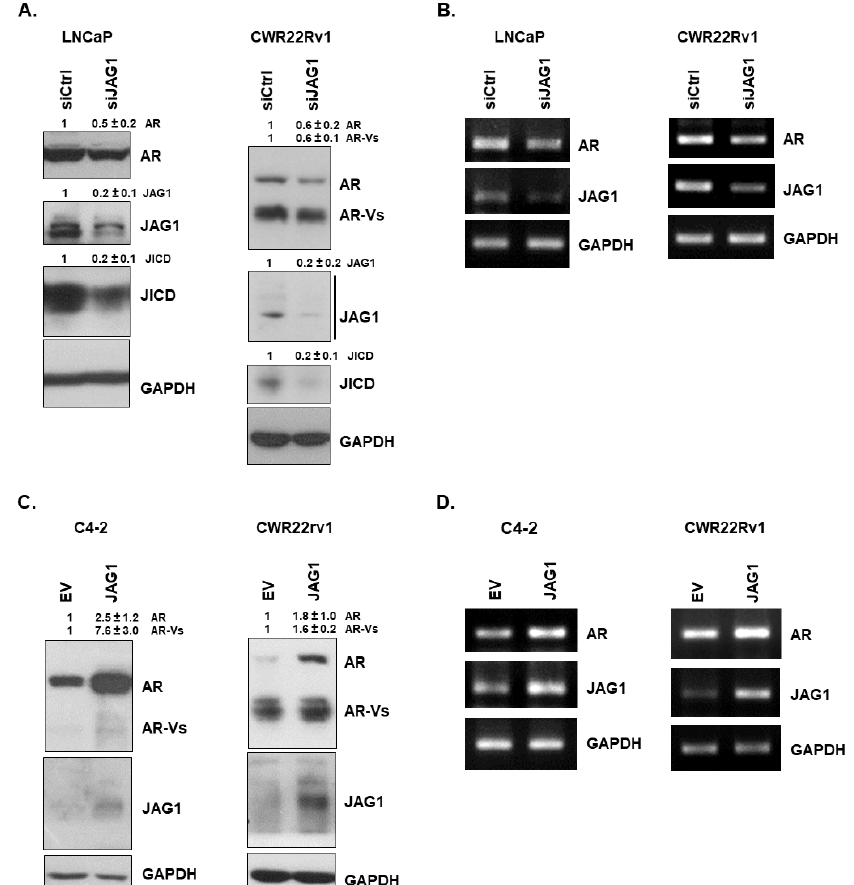
Figure 1. JAG1 regulates the expression of AR and AR–Vs. ( A , B ) Silencing of JAG1 decreases the expression of ARs. ( A ) Representative Western blot analysis showing the protein levels of AR and AR–Vs in siCtrl– or siJAG1–transfected androgen–dependent LNCaP and androgen-independent CWR22Rv1 cells. AR and AR–V proteins were detected using rabbit anti–AR (06–680, Millipore). ( B ) RT–PCR analysis showing the mRNA level of AR in siCtrl– or siJAG1–transfected LNCaP and CWR22Rv1 cells. RT–PCR analysis shows a decrease in total AR mRNAs, which contain exon 1– exon 2 (AR), in LNCaP and CWR22Rv1 cells when JAG1 was silenced. ( C , D ) Overexpression of JAG1 increases the expression of ARs. ( C ) Representative Western blot analysis showing the protein levels of AR and AR–Vs in EV– or JAG1–transfected C4–2 and CWR22Rv1 cells. AR and AR–V pro- teins were detected using rabbit anti–AR (06–680, Millipore). ( D ) RT–PCR analysis showing the level of AR mRNAs, which contain exon 3–exon 4 (AR), in EV or JAG1–transfected C4–2 and CWR22Rv1 cells. GAPDH was used as a loading control. Values above Western blots indicate the relative band intensity of each protein normalized to GAPDH and are shown as mean ± SD, which were obtained by densitometrical quantification of at least three independent experiments. All original uncropped Western blot and gel images are shown in Figure S7. 3.2. JICD Upregulates the Expression of AR-Vs in PC Cells We further examined whether JAG1 affected the expression of AR and AR-Vs through its processed JICD in PC cells because JAG1 and JICD expression levels were co- ordinated in the regulation of AR expression (Figure 1A). JICD overexpression in andro- gen-dependent LNCaP and androgen-independent CWR22Rv1 cells infected with